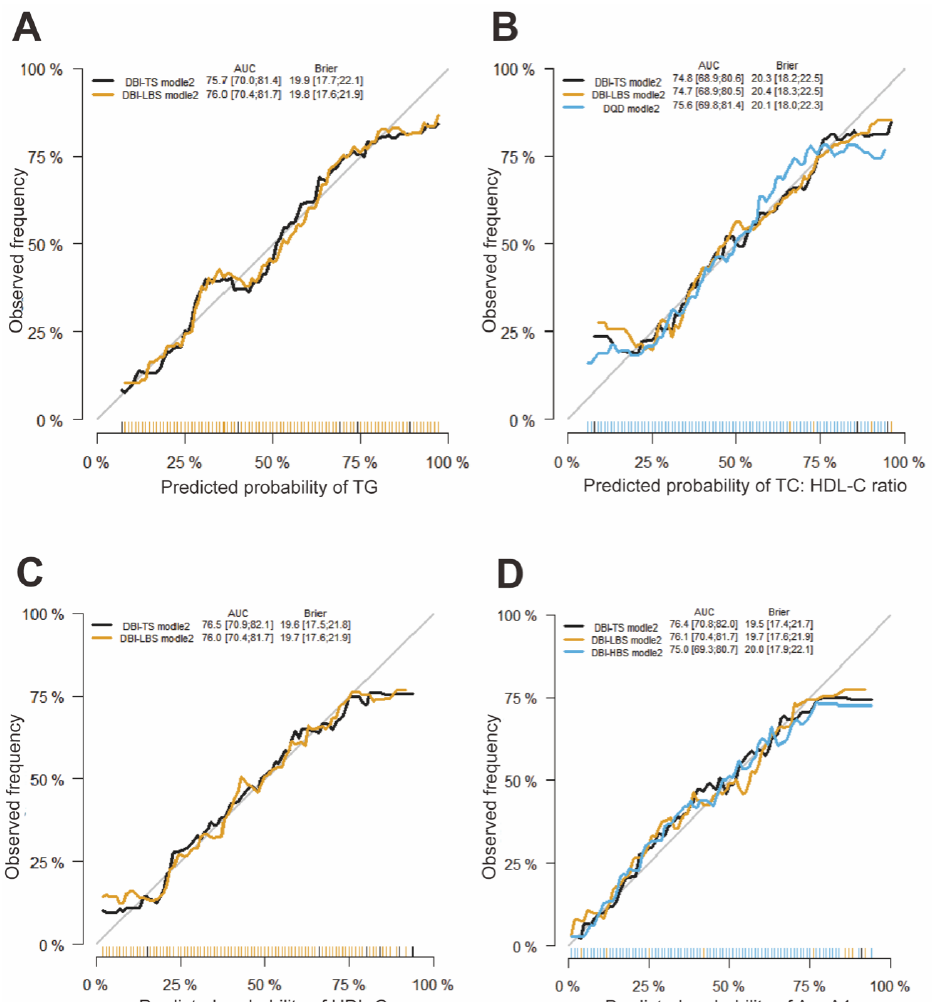
Figure 1. Receiver operating characteristic curve of the logistic regression models. The predicted probability of TG ( A ), TC:HDL-C ratio ( B ), HDL-C ( C ), and ApoA1 ( D ) were analyzed by logistic regression model adjusted for potential confounders, including age, sex, BMI, cigarette smoking,